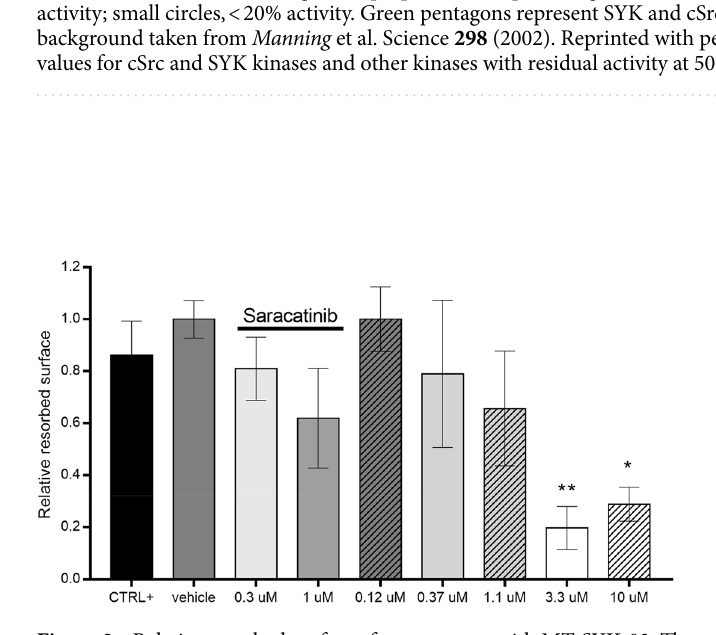
Figure 2. Relative resorbed surface after treatment with MT-SYK-03. The percentage of resorbed surface relative to the mean number of osteoclasts was calculated and compared to the vehicle control. Data are expressed as mean relative resorption ± SD (*p < 0.05; **p < 0.01) using Kruskal Wallis and Dunnet’s post